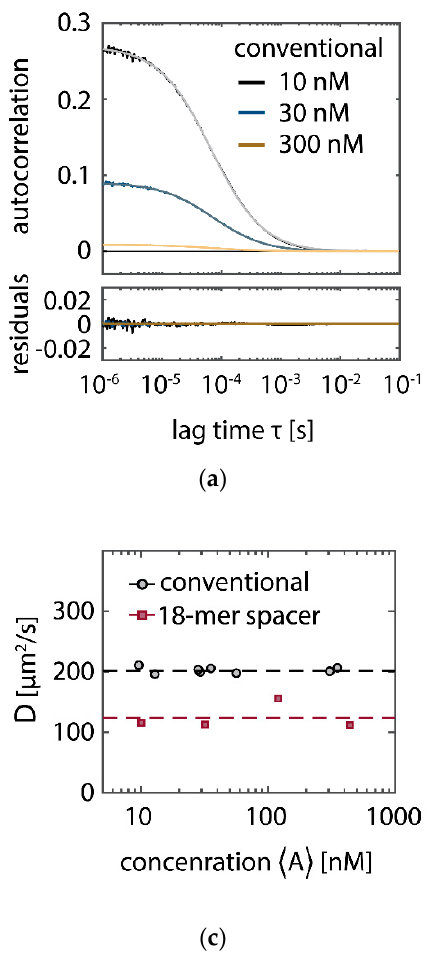
Figure A2. Confocal FCS measurement of the imager concentration and diffusion coefficient. (a) Representative autocorrelation curves for the conventional imager with their respective fits to a simple 3D diffusion model (Equation 7) and residuals. The three displayed curves have the target concentrations 10 nM (black), 30 nM (blue) and 300 nM (brown) and the measured concentrations 9.8 nM, 29.7 nM and 310 nM, respectively. (b) Normalized autocorrelation curves at the target concentration 10 nM for the conventional condition (identical to (a)) and the 18-mer spacer, leading to a decrease in the diffusion time. (c) Diffusion coefficient 𝐷 for the conventional and 18-mer spacer condition at different concentrations. The average diffusion coefficients (dashed lines) are determined as (mean ± std.) : (201 ± 5) µm 2 /s (in good agreement with previously reported results [15,72]) and (120 ± 20) µm 2 /s for the conventional and the 18-mer spacer, respectively. Based on the determined diffusion coefficients, we conclude that bleached imager within the TIRF excitation volume is predominantly recovered from solution by diffusion along the direction of the evanescent excitation. The diffusion time can be estimated as 𝑡 (cid:3005) ~ 𝑑 ev(cid:2870) 𝐷⁄ , with 𝑑 ev being the evanescent field of the TIRF illumination. Assuming the penetration depth as 𝑑 ev ~75 nm [74], we obtain 𝑡 (cid:3005) ~50 µs , three orders of magnitude faster than the PAINT exposure time (200 ms) or the minimal SI-FCS correlation time (100 ms). In the high irradiance regime ( 𝐼 (cid:2868) = 0.2 kW/cm 2 ), the rate of photo-bleaching within the TIRF illumination can be assumed four orders of magnitude slower than the recovery by diffusion, based on the bright times found for the conventional condition, which is shortened by photo-bleaching to 𝜏 (cid:3003) ~2 s (Figure 3b). Raw data of confocal FCS measurements is available as supplementary material.